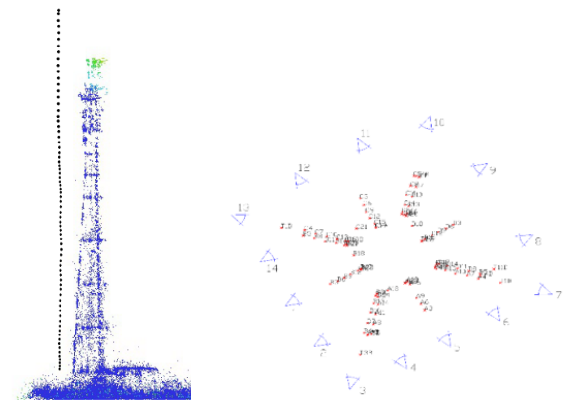
Figure 3. Trajectory Figure 4. Strips acquisition